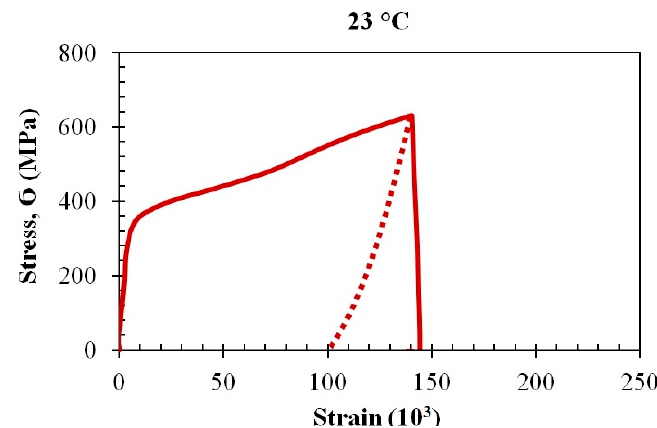
Figure 1. Stress–strain curve of NiTi SMA.